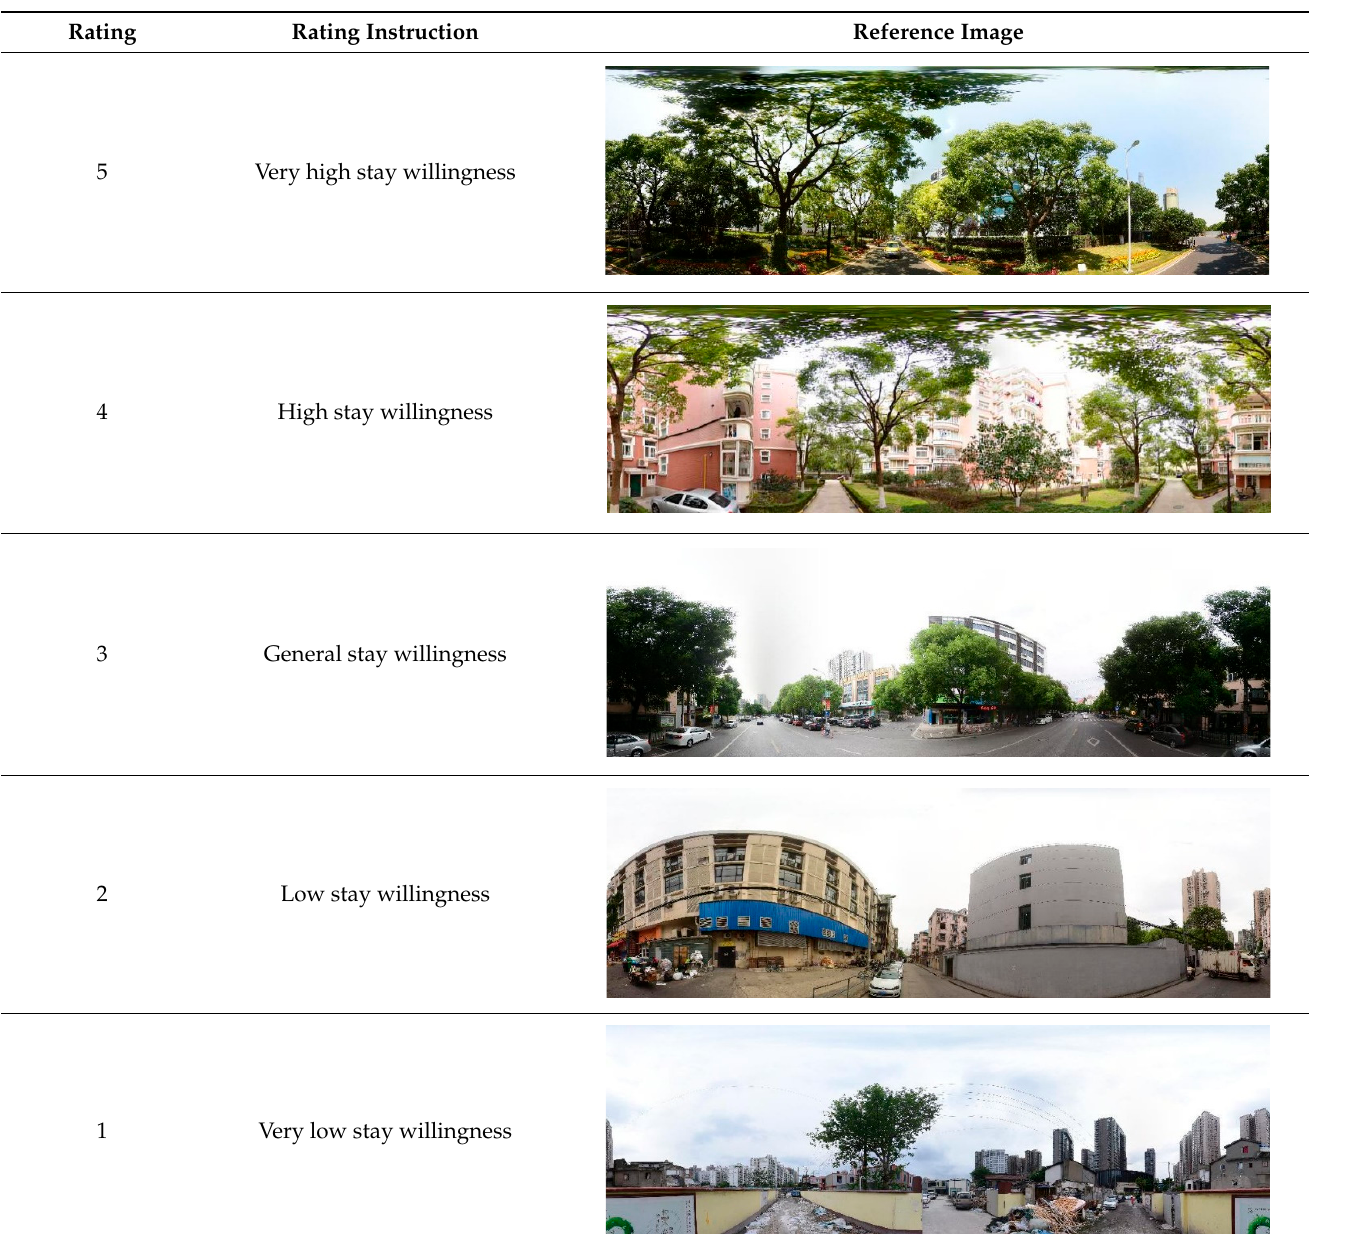
Table 3. Examples of the rating criteria for people’s willingness to stay corresponding to the quality of the street space.